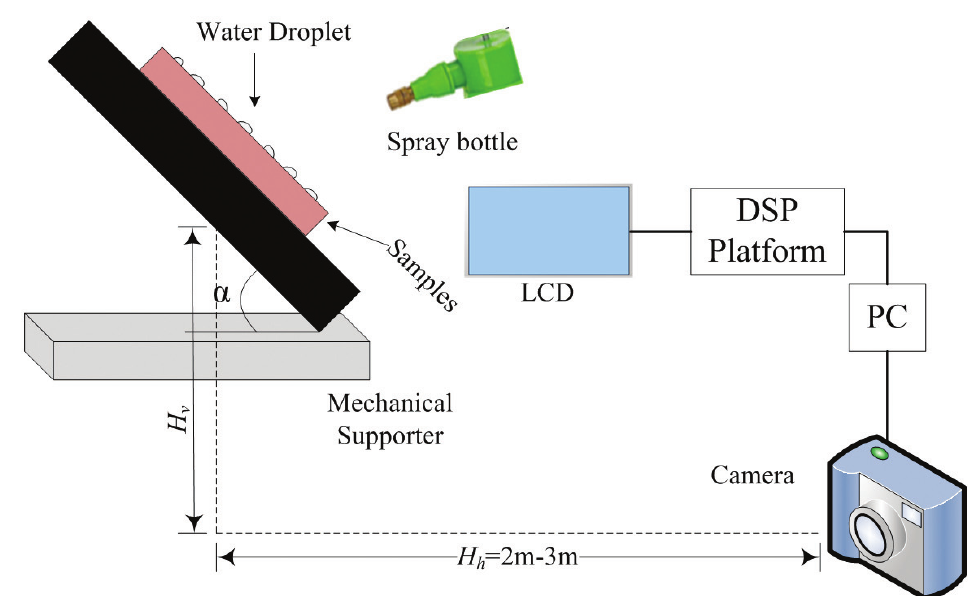
Figure 1. Illustration of